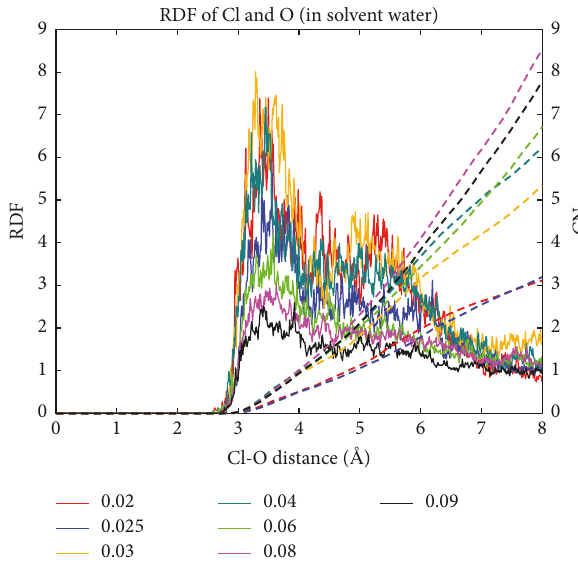
Figure 6: Radial distribution function (RDF, solid lines, left axes) and the coordination number (CN, dash lines, right axes) as a function of the Cl-O distance of Cl versus O in solvent water (excluded water molecule in [CuCl(H 2 O)] 0